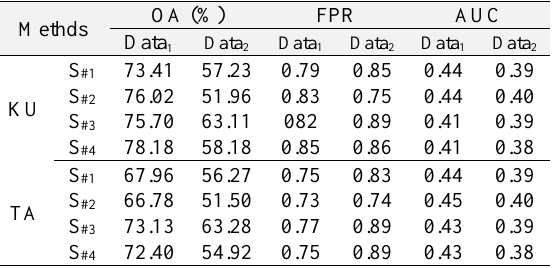
Table 8. Results of CA and ED algorithms